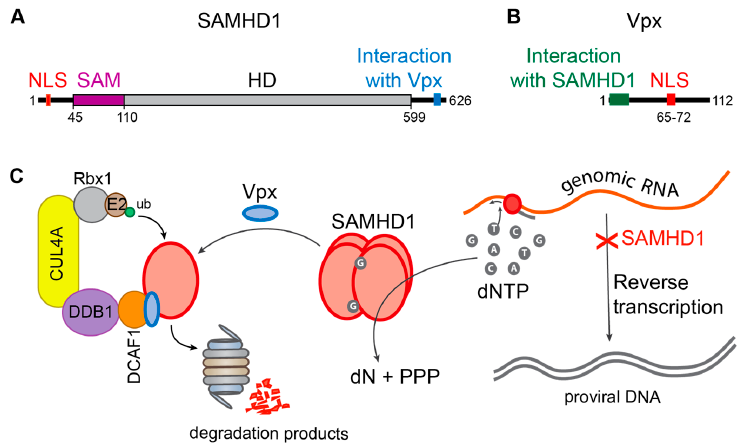
Figure 5. Restriction of HIV by SAMHD1 and counteraction by Vpx. ( A , B ) Schematic representation of the main domains of ( A ) SAMHD1 and ( B ) Vpx. The nuclear localization signal (NLS) is indicated in red. Amino acid positions of the beginning and end of the domains as well as the total length of the proteins are indicated; ( C ) the mechanism of SAMHD1 restriction and Vpx counteraction. Tetrameric SAMHD1 (red) hydrolyzes dNTPs, leading to a block of reverse transcription of the viral genome. Vpx (blue) induces SAMHD1 ubiquitination followed by its degradation by the proteasome.